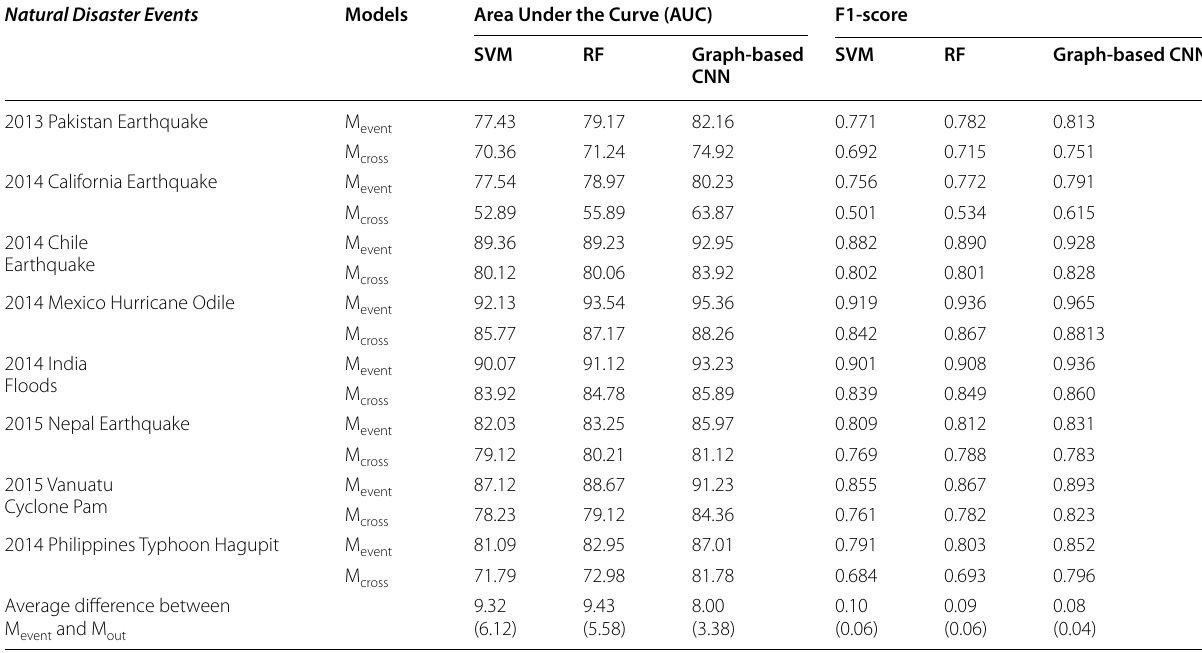
Table 2 Binary classification results of tweets (perception-level situational awareness) Natural Disaster Events